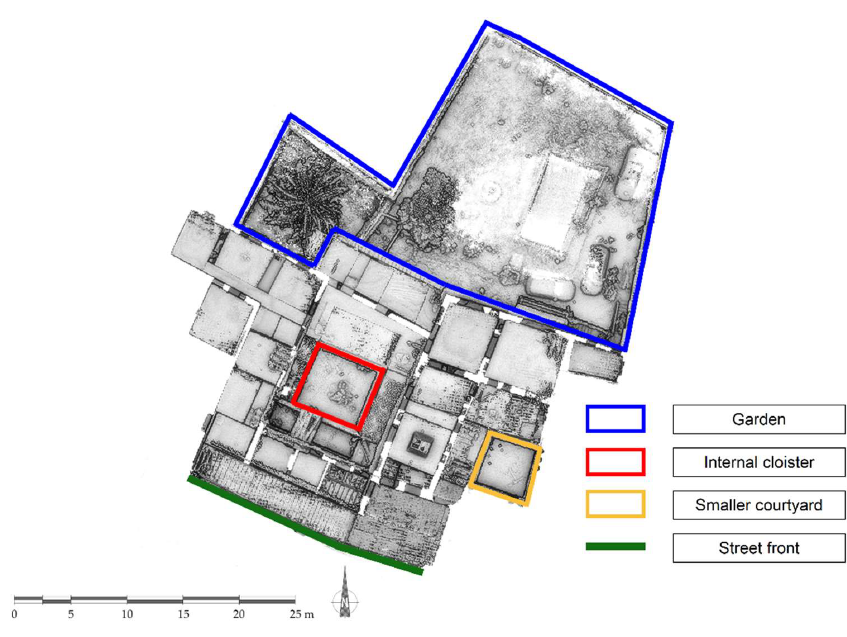
Figure 9. Plan view of the case study.